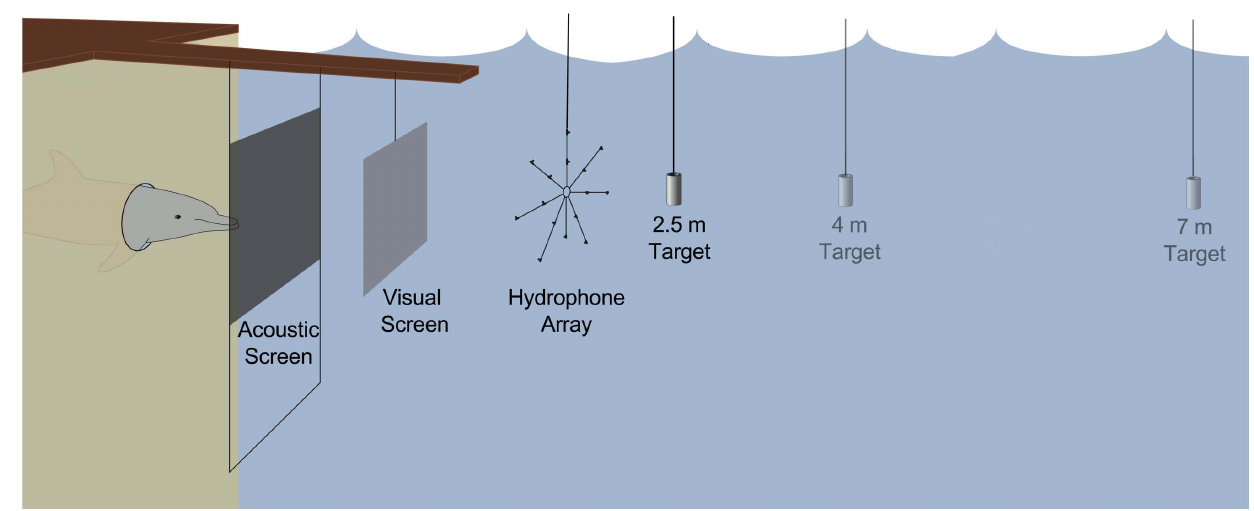
Figure 1. Experimental setup of the target pen. During a trial, the dolphin positioned herself into the underwater hoop 1 m below the surface of the water. An acoustically opaque metal screen was located inside the target pen, in front of the animal, to prevent her from echolocating prematurely on the targets (acoustic screen). An acoustically transparent, yet visually opaque polyethylene screen was placed in front of the acoustically opaque screen to ensure the subject did not use visual cues during target detection (visual screen). After the target was lowered 1 m into the water, the acoustically opaque screen was moved to reveal the target. The animal ensonified the target located behind the array (positioned at either 2.5, 4 or 7 m) and the hydrophone array recorded the emitted echolocation signals.